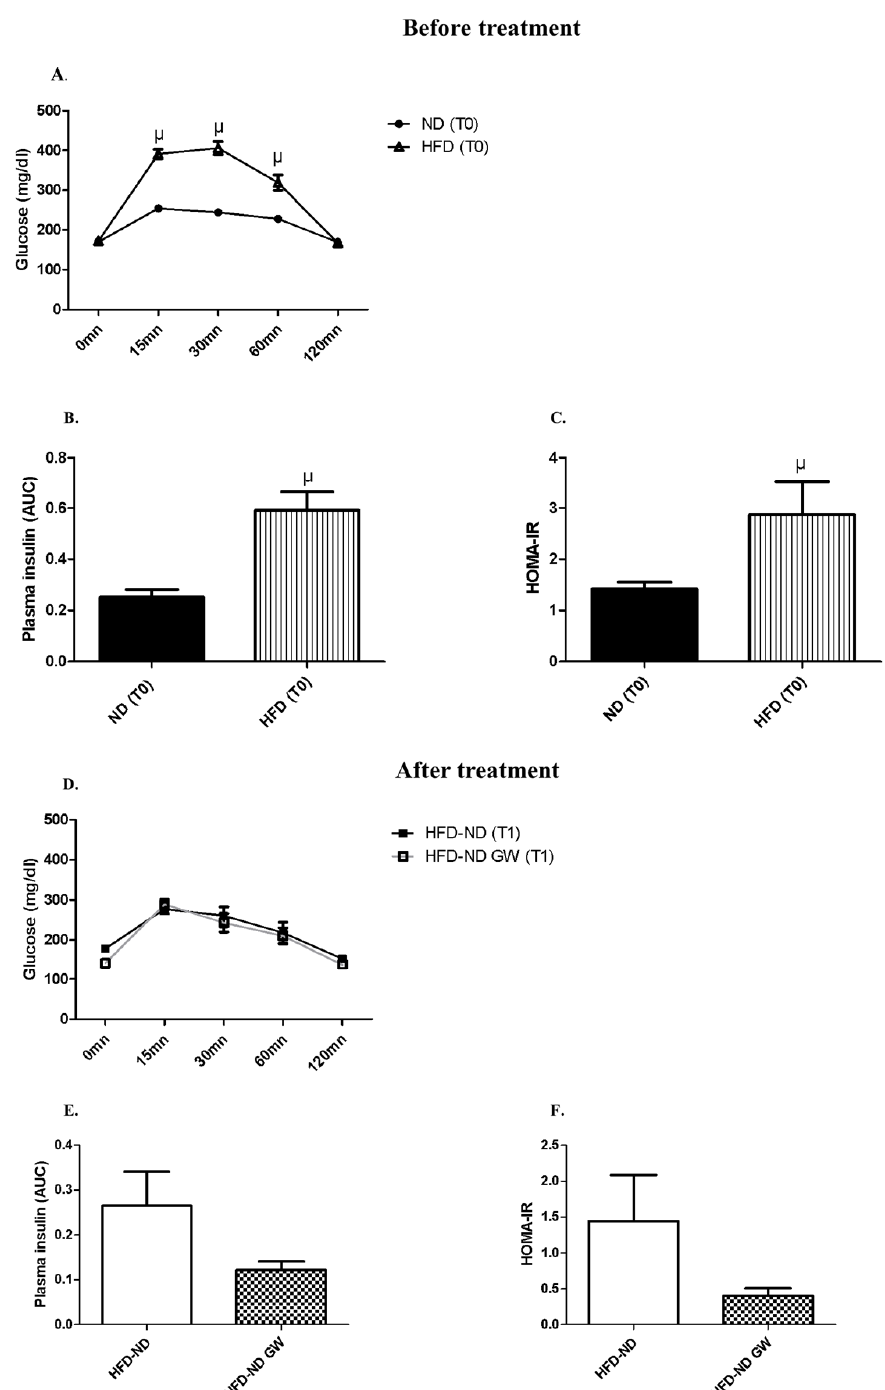
Figure 2. Glucose tolerance curves and insulin plasma concentrations at T0 (after 12-week HFD) and T1 (after 8-week-returning to a ND). ( A ) Glucose tolerance test (GTT) at T0, i.e. after 12-weeks HFD ( n = 12) or ND ( n = 6); ( B ) Plasma insulin Area Under the Curve (AUC) during GTT at T0; ( C ) HOMA-IR index calculated with basal blood glucose (mmol / L) and blood insulin during GTT at T0. ( D ) GTT at T1 after returning to ND only (HFD-ND, n = 6) or combined with a PPAR β / δ agonist (GW0742) treatment (HFD-ND-GW, n = 6). ( E ) Plasma insulin (AUC) during GTT at T1; ( F ) HOMA-IR index at T1. Data are shown as mean ± SD. µ p < 0.05 vs. ND at T0.